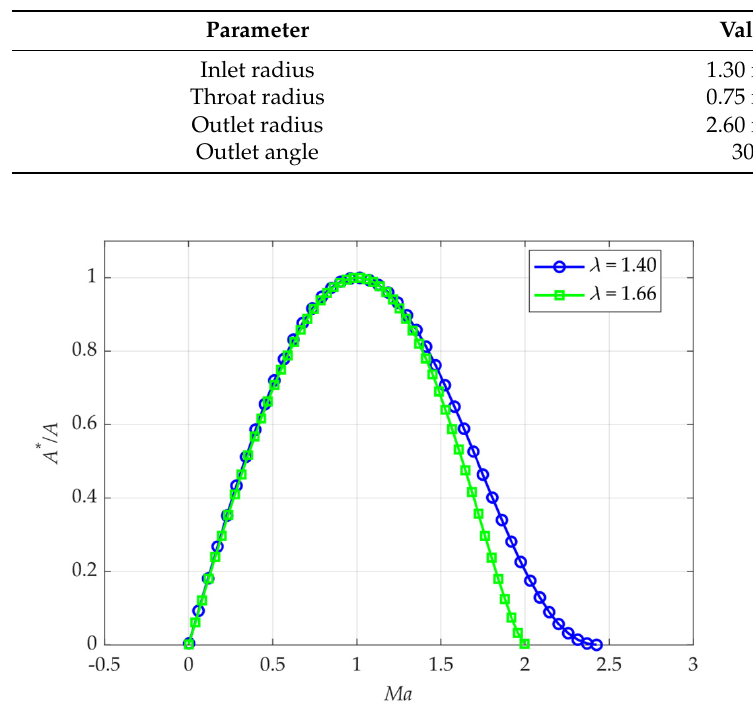
Figure 3. Relationship between Ma and A * / A ( x ). The x-axis represents the Mach number, which is √ the ratio of the jet speed to the local speed of sound (the blue line intersects the x-axis at 6, and the green line intersects the x-axis at 4389/33). The y-axis represents the ratio of the cross-sectional area of the throat to any cross-sectional area of the